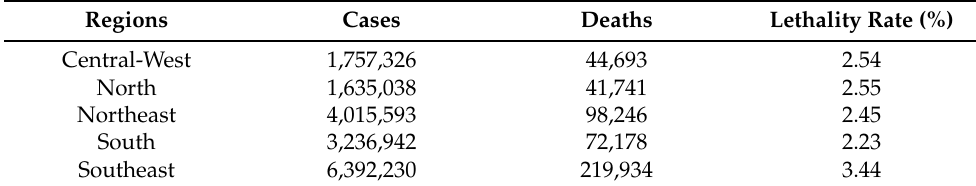
Table 1. COVID-19 statistics by regions of Brazil (update on 2021-06-08). Regions